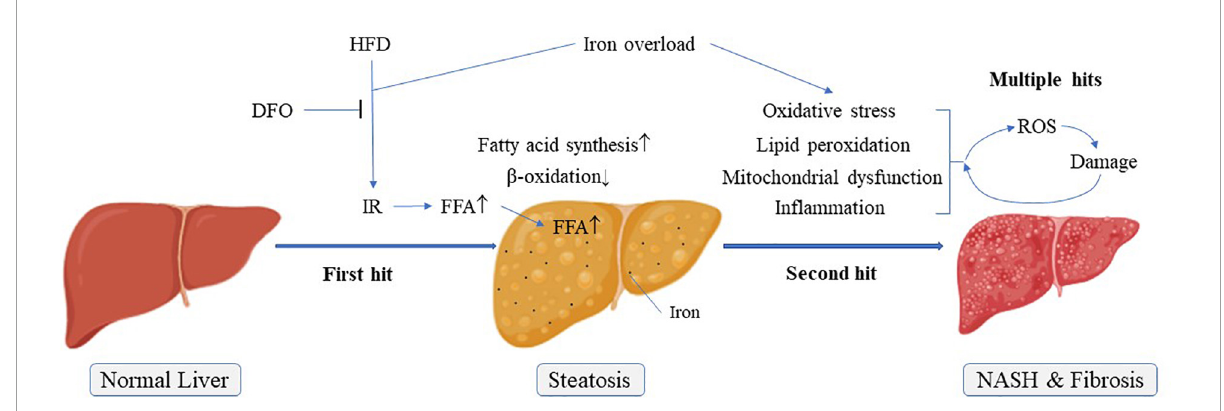
FIGURE7 Possible pathogenesis of NAFLD “multiple hit theory”. IR, Insulin resistance; NASH, Non-alcoholic